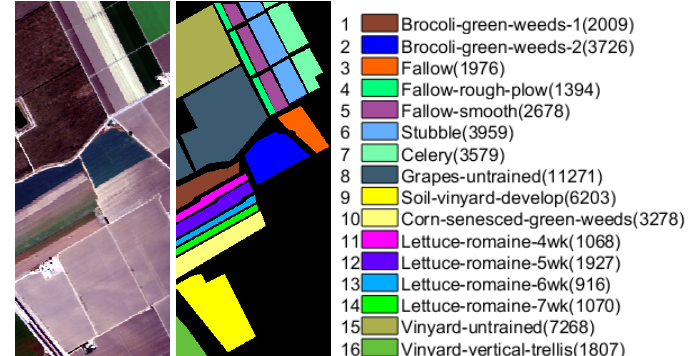
Figure 2. The false color composition and ground truth of Salinas data with numbers of samples for each class in brackets.